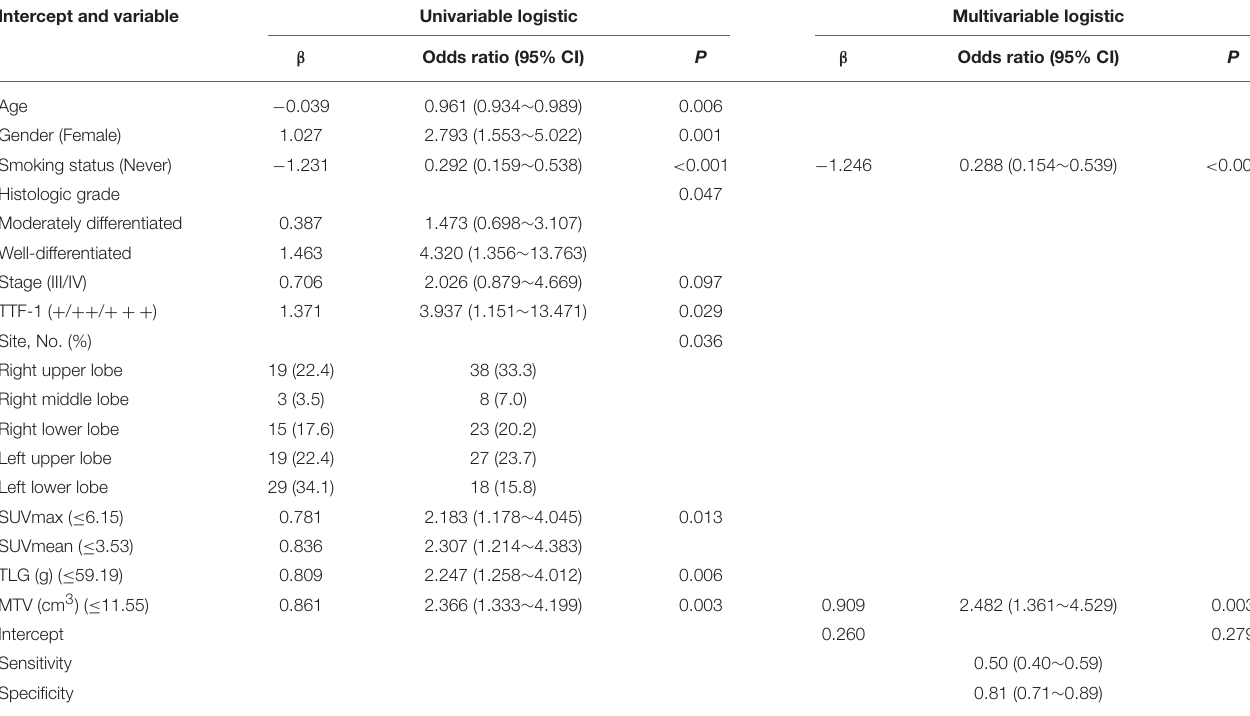
TABLE 3 | Univariate and multivariate analysis of various predictive factors for the EGFR status in lung adenocarcinoma. Intercept and variable Univariable logistic